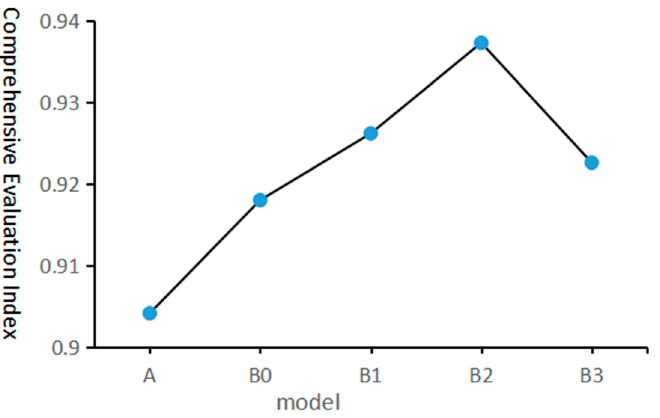
Figure 10. Comprehensive evaluation index of precipitation models in Central China.